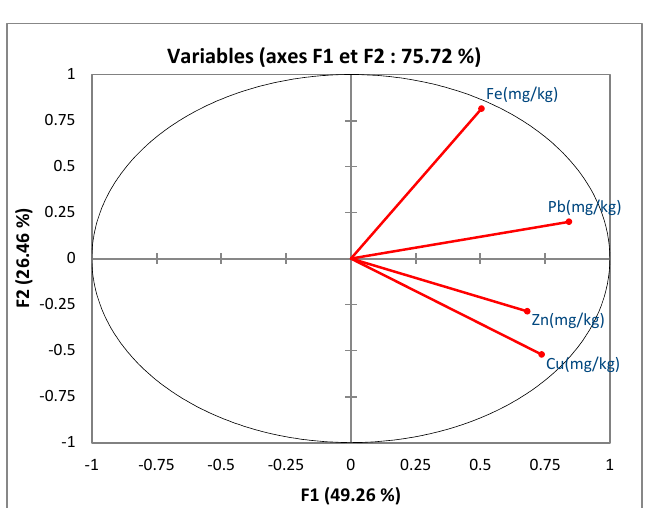
Figure 7. F1xF2 factorial design of variables. The samples (those in the black circle with Cladophora 2, typically) positioned around the origin of the axis demonstrate random values for the factors under consideration (Fig ‐ ure 8).